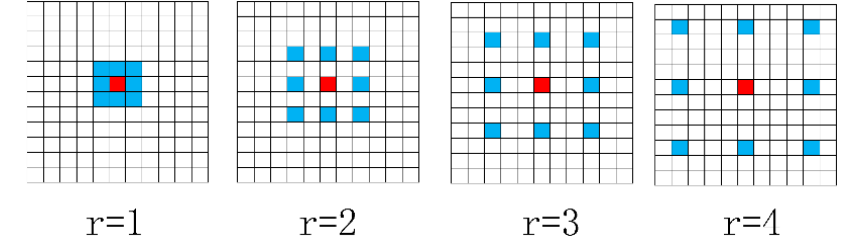
Figure 5. Convolution filters with different dilation rates.